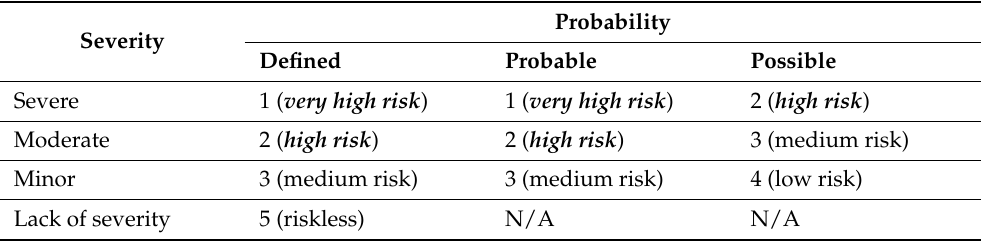
Table 1. Levels of the clinical relevance of drug interactions according to the combination of severity and probability of occurrence